Question: State the chart type depicted above.
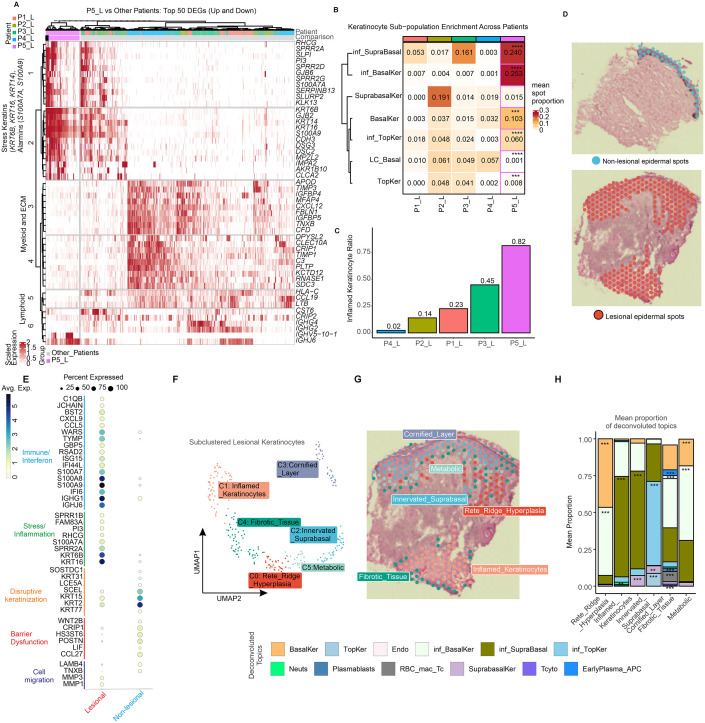
Answer: heatmap